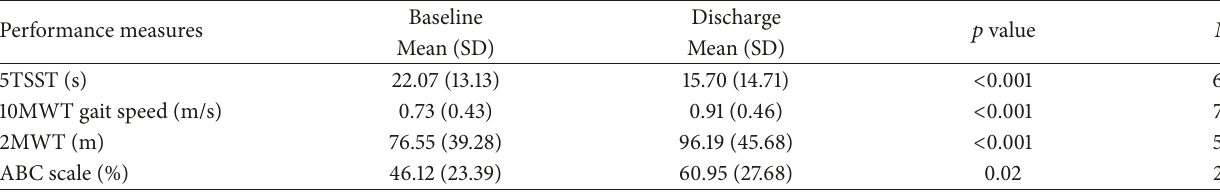
Table 4: Performance measure comparison of baseline to discharge (raw scores).